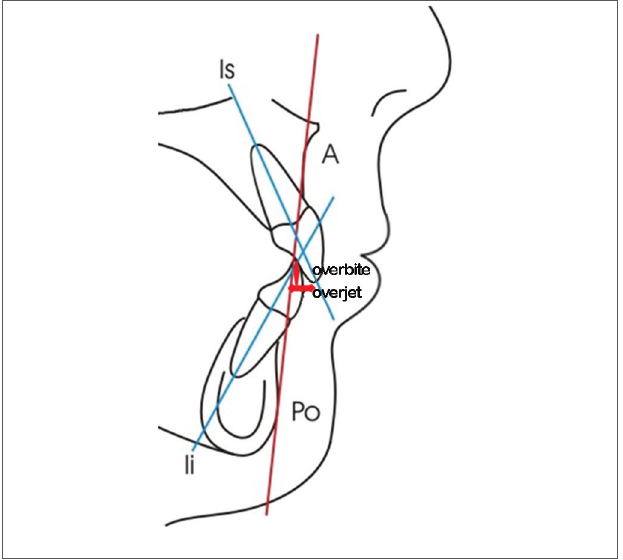
Figure 3. Overbite (vertical measure) and overjet (horizontal measure